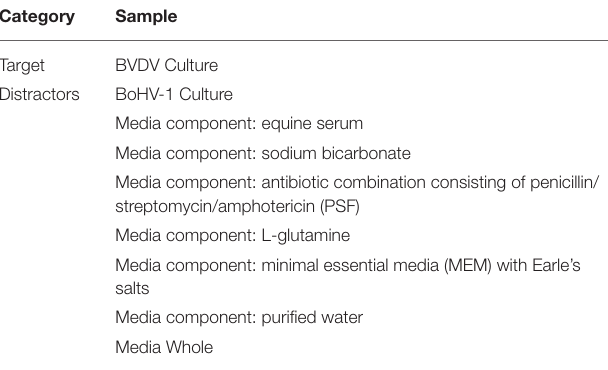
into the room to sample the wheel. The experimenter signaled TABLE 1 | Culture POCR training and testing list. The list of target and distractors used in the training and testing of culture